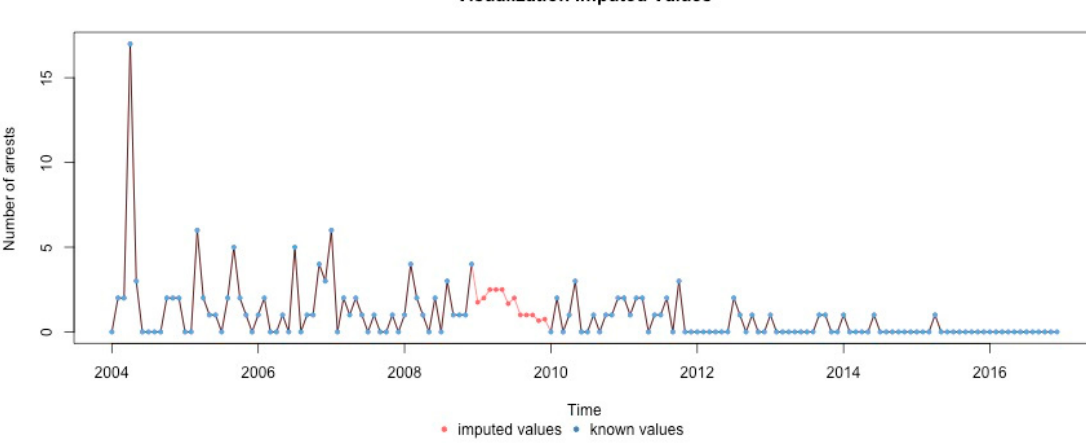
Figure A18. Heroin foreign nationals arrests 2004–2016 in the Czech Republic—imputed missing values.